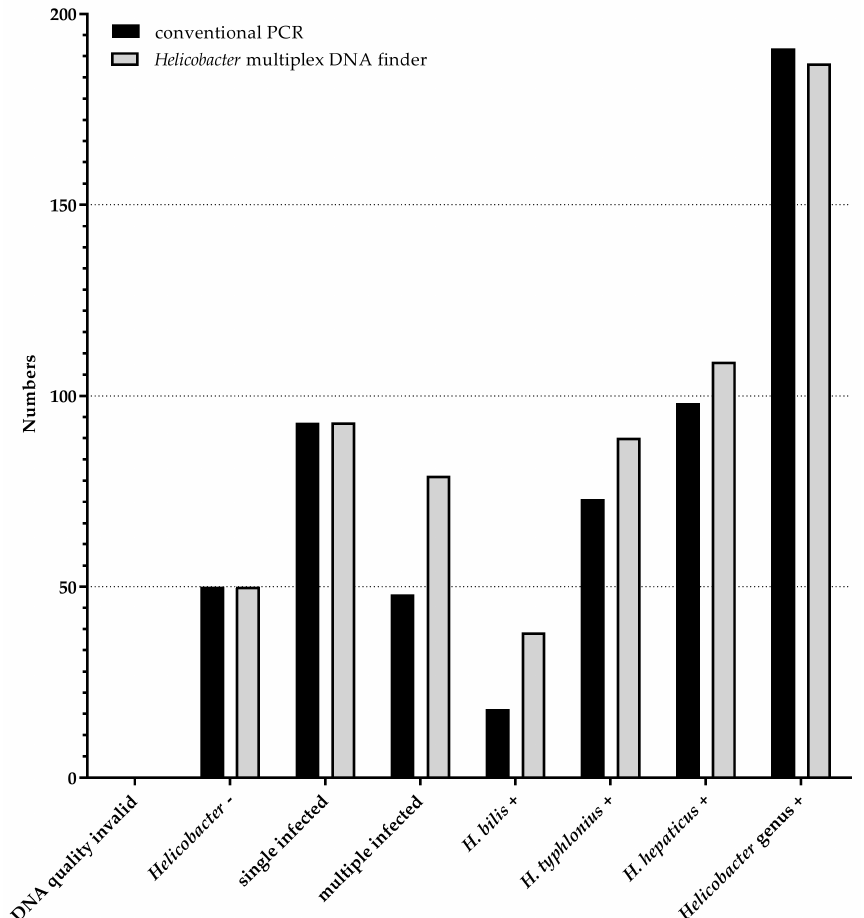
Figure 1. Identification of Helicobacter by Helicobacter multiplex DNA finder (grey bars) and con- ventional PCR (black bars). Numbers of samples defined as Helicobacter -negative, single- (i.e., only one Helicobacter spp. identified in one sample) and multiple-infected. H. bilis , H. typhlonius , H. hepaticus , Helicobacter genus positive are shown on the y-axis. The chi-squared test of indepen- dence indicated strong correlation between conventional PCR and the Helicobacter multiplex DNA finder ( p < 0.0001) for any parameter compared ( Helicobacter -, single-infected, multiple-infected, H. bilis , H. typhlonius , H. hepaticus and Helicobacter